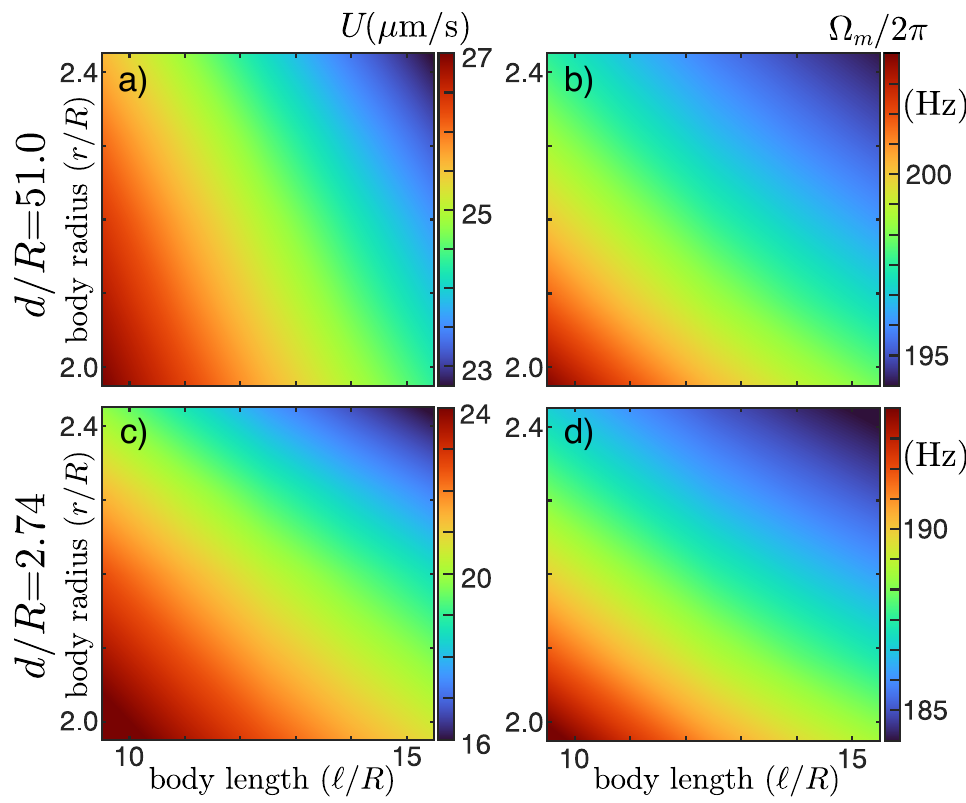
Figure 11. Free-swimming speed U and motor frequency Ω m /2 π shown as heat maps with axes cylindrical radius ( r / R ) versus body length ( (cid:96) / R ). The data are for a fixed flagellum wavelength, λ / R = 11.1, where R is the helical radius. The top row ( a , b ) is far from the boundary d / R = 51.0 data, where boundary effects are minimal, and the bottom row c and d are data close to the boundary d / R = 2.74. The swimming speed data in ( a , c ) show that short, thin bodies result in higher swimming speed both near and far from the boundary, though near the boundary the swimming speed is lower for a given body geometry. Therefore, the swimming speed measure predicts that short, thin bodies far from the surface result in a better motility performance. The motor frequency data in ( b , d ) show that long, thick bodies result in a slower motor frequency near and far from the boundary, though far from the boundary, the motor frequency is higher. Therefore, the motor frequency measure predicts long, thick bodies near the surface result in better motility